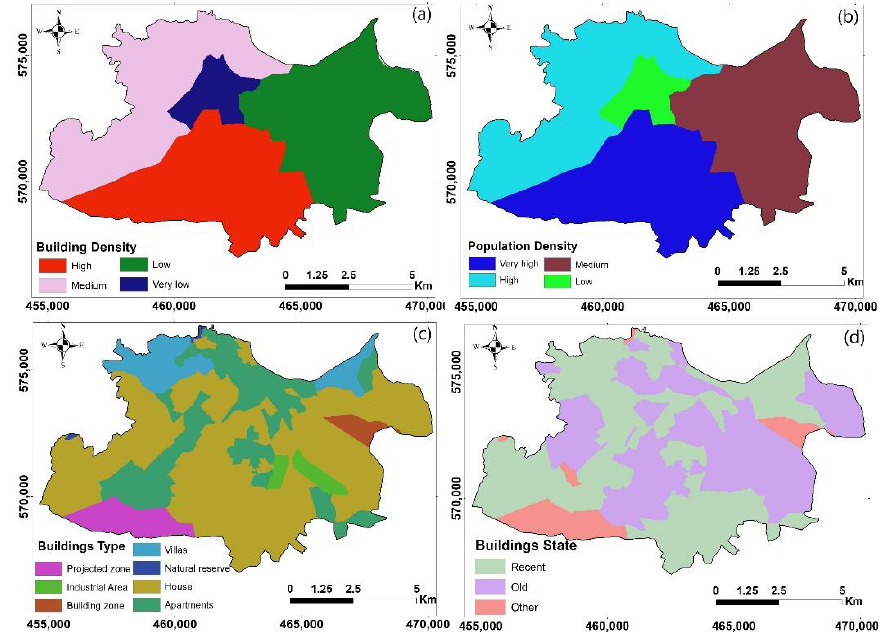
Figure 4. Map of the socio-environmental factors in the study area: ( a ) building density; ( b ) population density; ( c ) building type; and ( d ) building state.